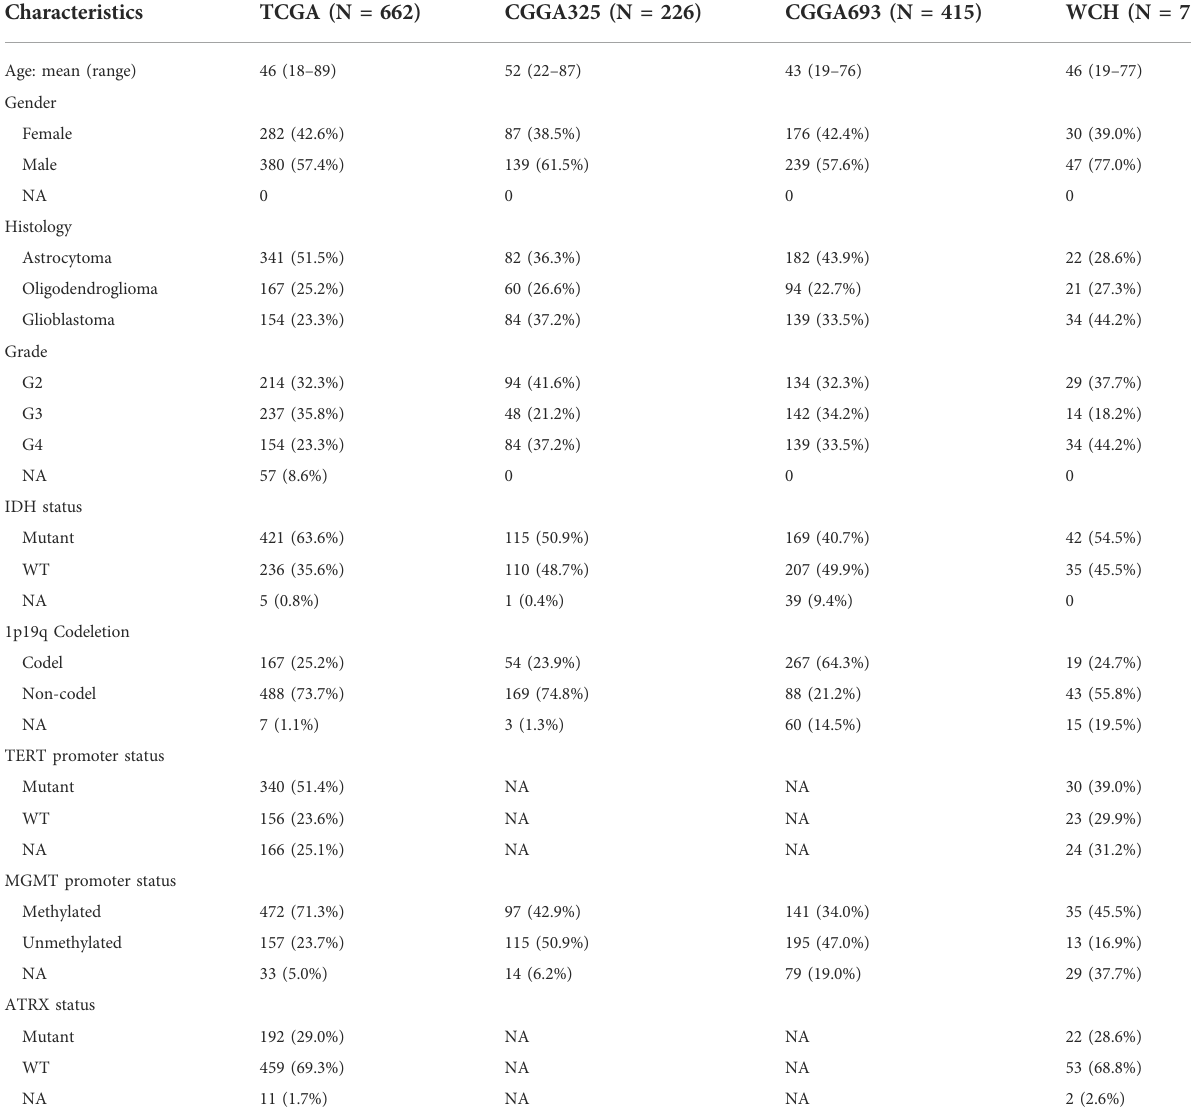
TABLE 1 Clinicopathological characteristics of patients in TCGA, CGGA325, CGGA693, and WCH cohorts.